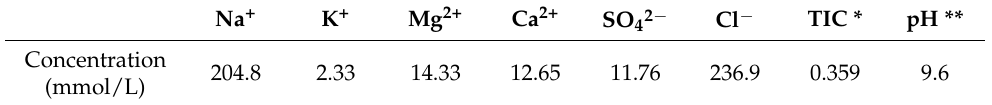
Figure 1. Schematic diagram of the settings for the CI experiment [22]. Dotted rectangles indicate the sampling location for each core sample. Samples BCI-12 and BCI-15 were sampled after 4.9 years, samples BCI-19 and BCI-20 10 years after emplacement of the materials. OPC: ordinary Portland cement; Table 1. Composition of the artificial pore water (APW).